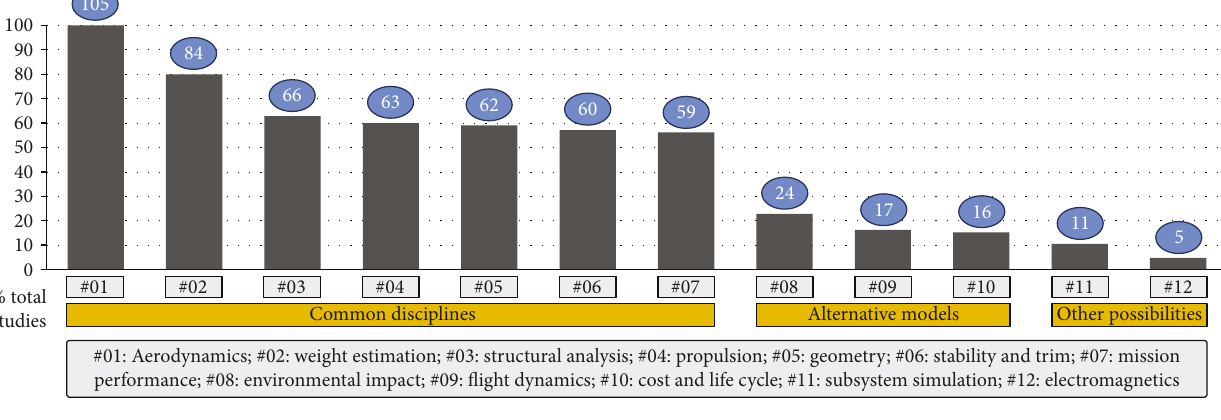
Figure 4: The main categories and the reoccurrence frequency of the disciplinary